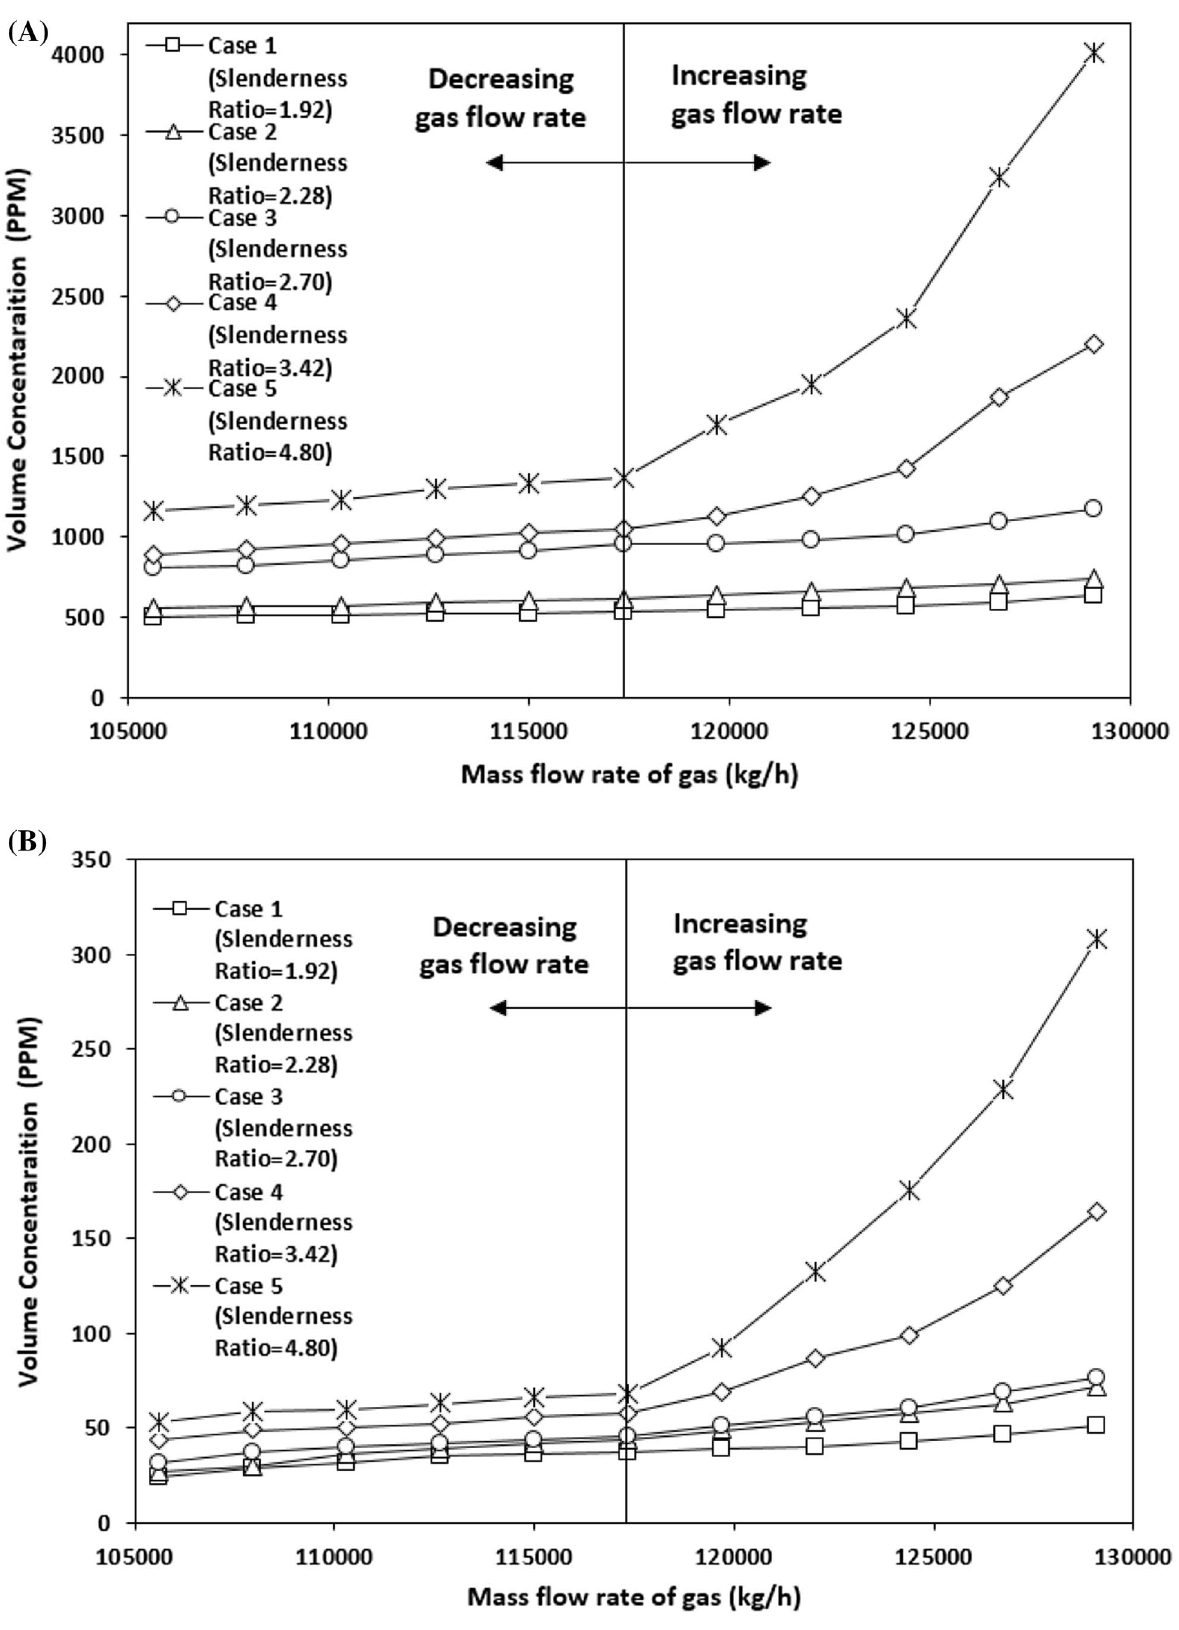
Fig. 18 Effect of input gas rate on the amount of natural condensate ( a ) and water ( b ) in the gas